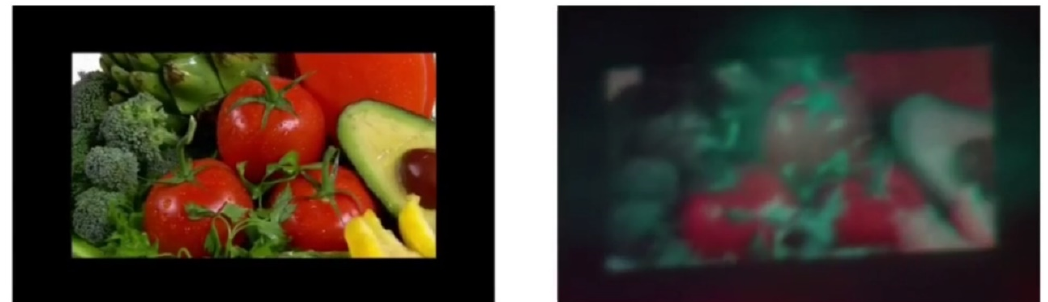
Figure 13. Screenshot of Video “Vegetables.” This video is provided in the Supplementary